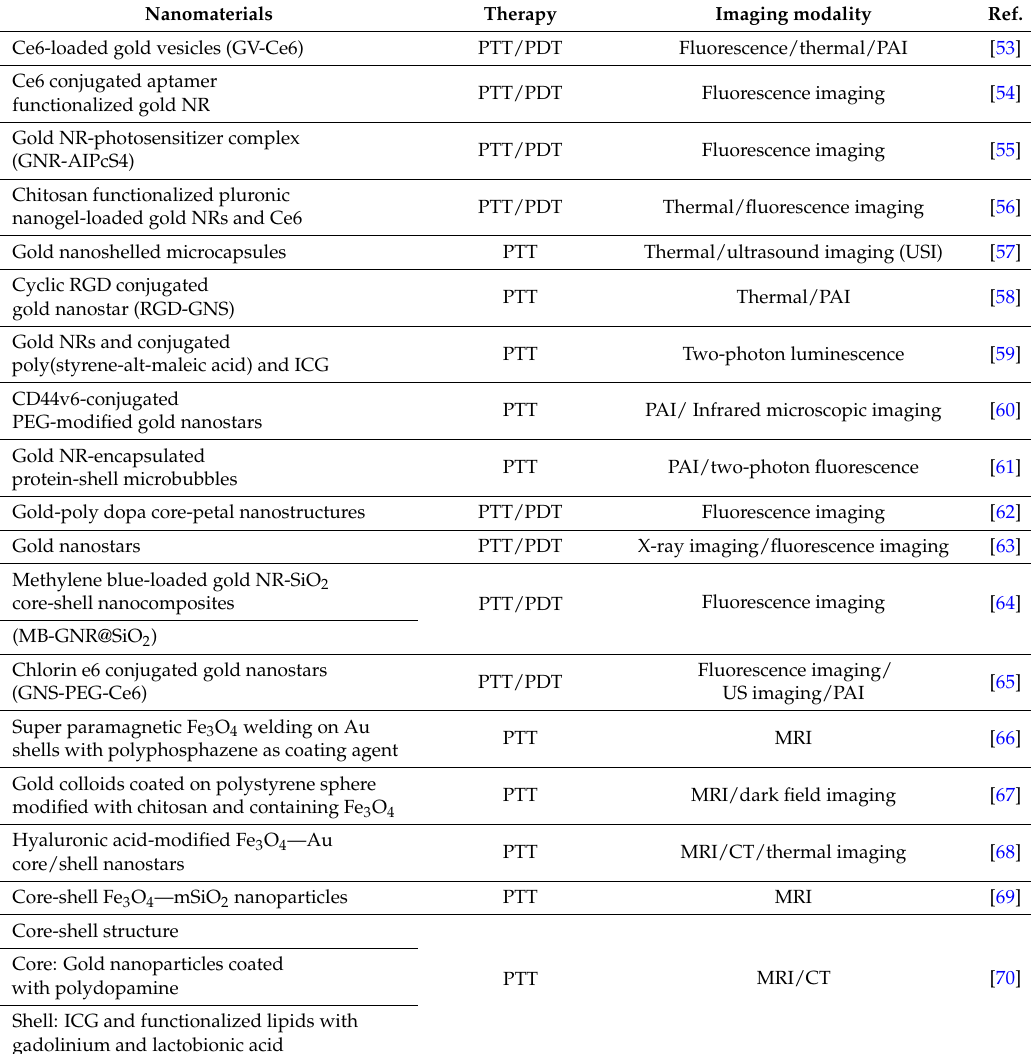
Table 1. Various types of multifunctional gold nanoparticles used in image-guided therapies.